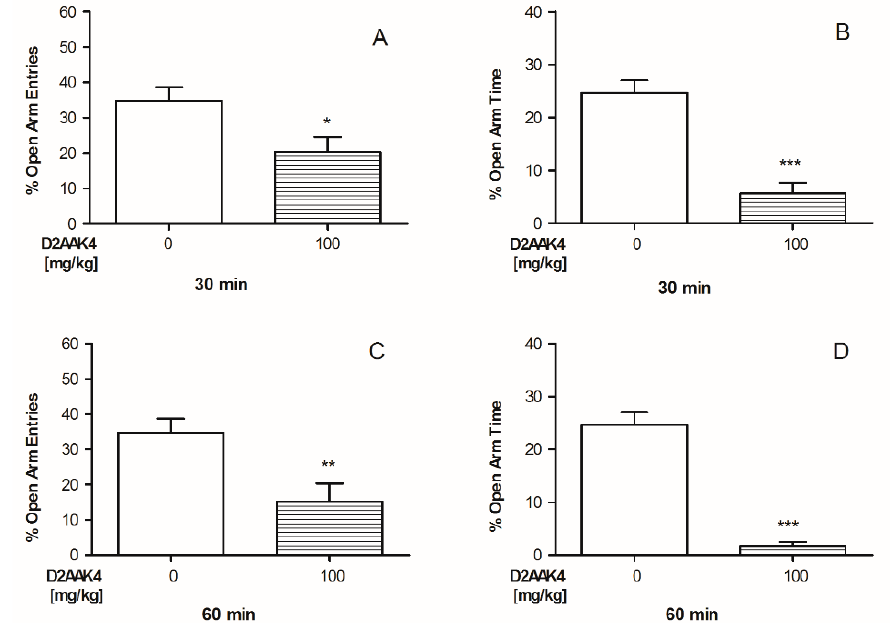
Figure 10. Acute effect of D2AAK4 on anxiety-like responses in mice evaluated 30 and 60 min after treatment using elevated plus maze (EPM) test. Percentage (%) of open arm entries ( A , C ) and % of time spent in the open arms ( B , D ) recorded 30 ( A , B ) and 60 ( C , D ) minutes after 100 mg/kg D2AAK4 injection ((n = 8) and vehicle (n = 8, indicated as 0); i.p). Data are presented as mean ± SEM. The results from the t-test analyses indicate the anxiogenic activity elicited by D2AAK4 30 and 60 min after treatment *** p < 0.001 for time spent in the open arms (both 30 and 60 min) and for open arm entries (30 min: * p = 0.0272 and 60 min: ** p = 0.0092).